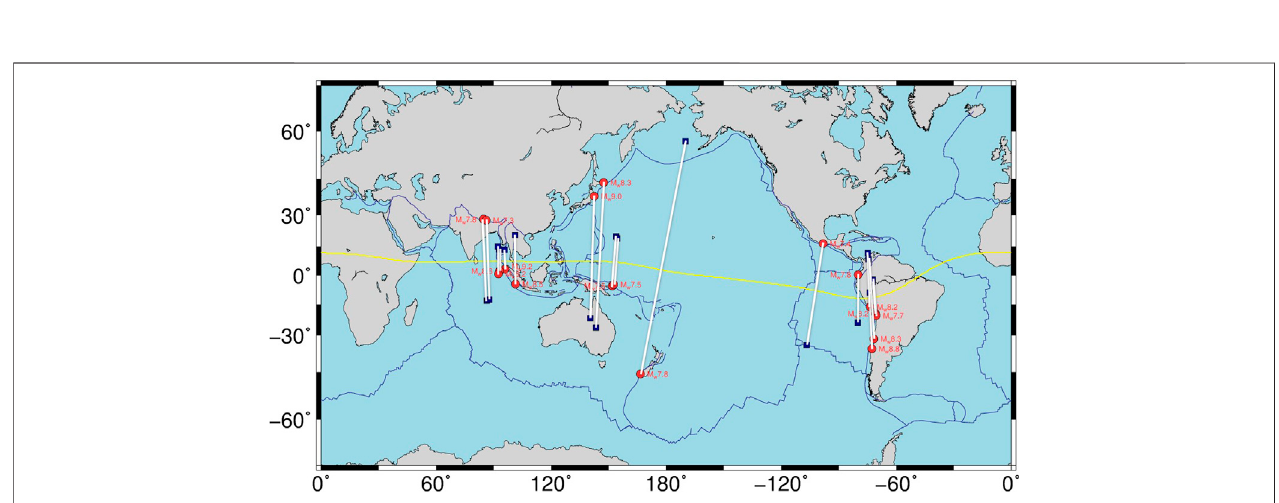
FIGURE 6 | The epicenters (red circles) of eighteen earthquakes ranging from M w 7.3 to M w 9.2 with possible preseismic ionospheric TEC anomalies and their correspondingconjugatepoints (bluesquares).Thewhitecurves showgeomagnetic fi eldlines.The yellow curve showsthemagnetic equator. Thenumbersofavailable GNSSstationsarenotsuf fi cientwhentheseearthquakesoccurredexceptforthe2011Tohoku-oki(presentstudy)andthe2015Illapel(HeandHeki,2018)earthquakes.